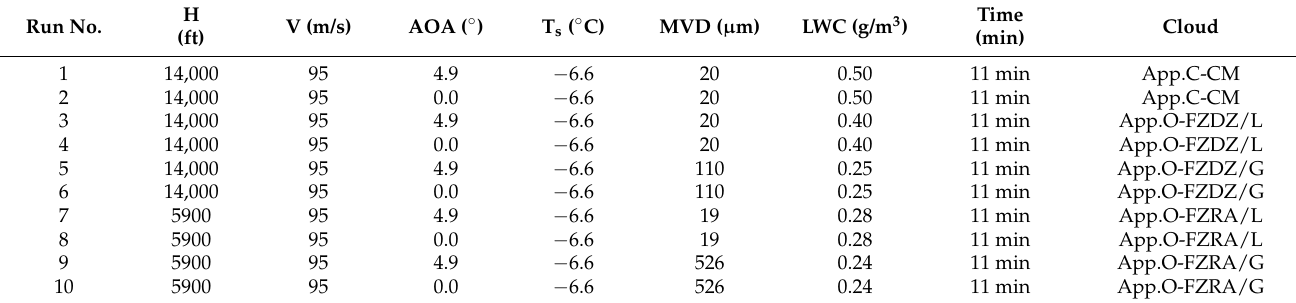
Table 1. Test conditions.